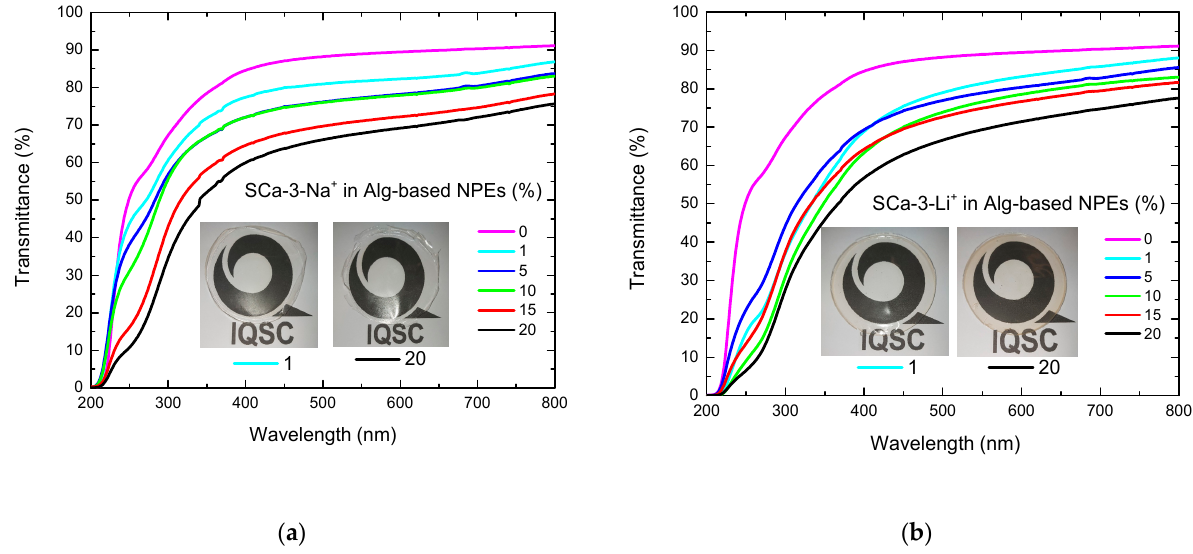
Figure 3. Transmittance spectra for Alg-based NPEs with 0–20 wt% of ( a ) SCa-3-Na + and ( b ) SCa-3-Li + . Inset photos of Alg-based NPEs with 1 and 20 wt% of clay.